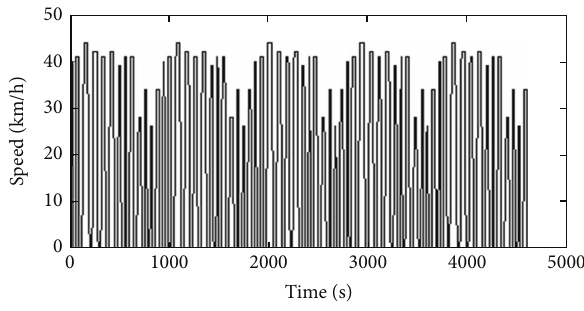
Figure 4: The estimated whole trip